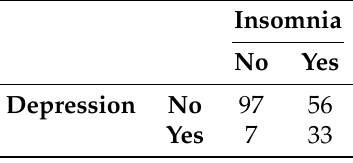
Table 3. Cross-classification of depression and insomnia cases.